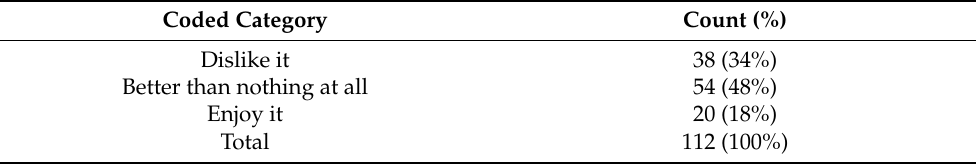
Table 3. Attitude Towards Playing D&D